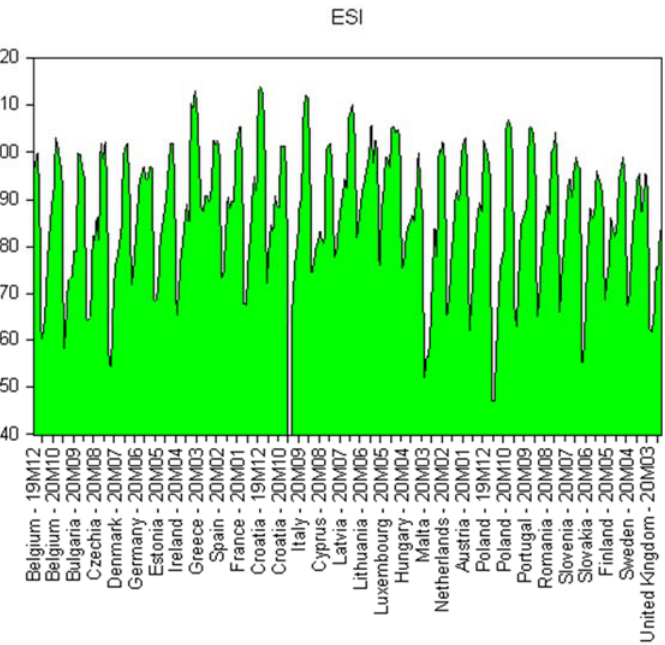
Figure 1. Evolution of the economic sentiment indicator ( ESI ) across the country sample. Note : Fi ‐ gures displayed after the symbol M indicate the number of the month in the calendar year.